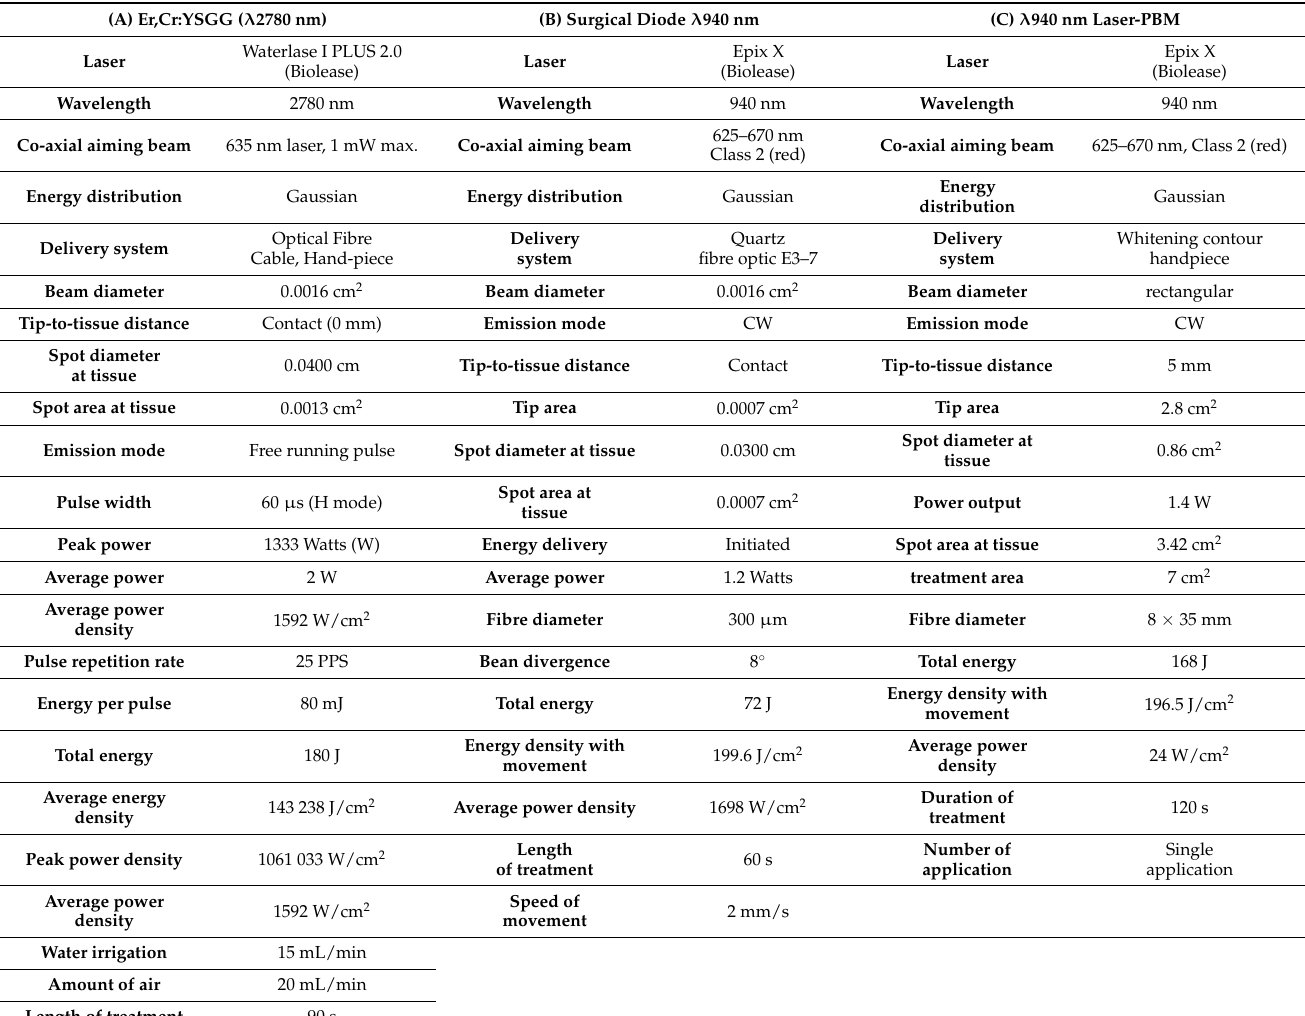
Table 1. ( A – C ). ( A ) Description of the utilised laser and the adjustable and calculated laser operating parameters of λ 2780 nm. ( B ) Description of the laser utilised and the adjustable and calculated laser operating parameters of λ 940 nm. ( C ) Description of the λ 940 nm laser-PBM utilised and the adjustable and calculated laser operating parameters. Abbreviations: Er,Cr:YSGG, Erbium Chromium: Yttrium Scandium Gallium Garnet; CW, continuous emission